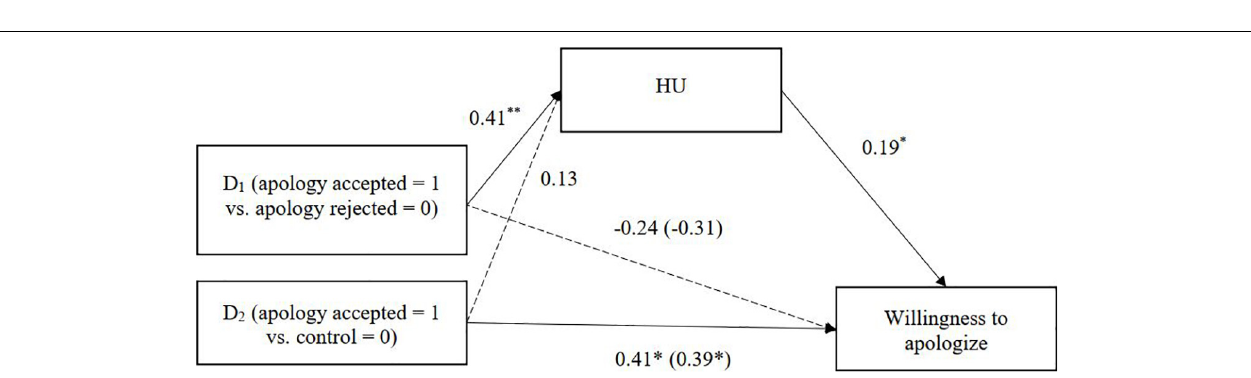
FIGURE 4 | HU mediating the relationship between perceived apology acceptance and willingness to help (Study 2). Unstandardized coefficients are presented. Coefficients in parentheses denote direct effects after controlling for indirect effects. ∗∗ p < 0.01.